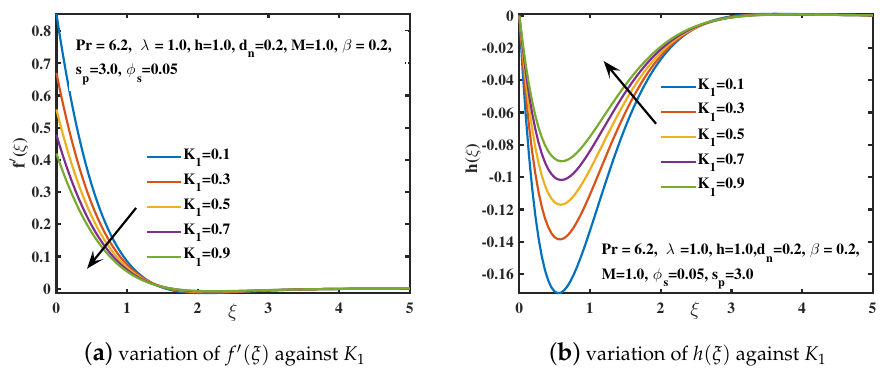
Figure 6. The f (cid:48) ( ξ ) and h ( ξ ) curves for distinct slip parameter K 1 values.